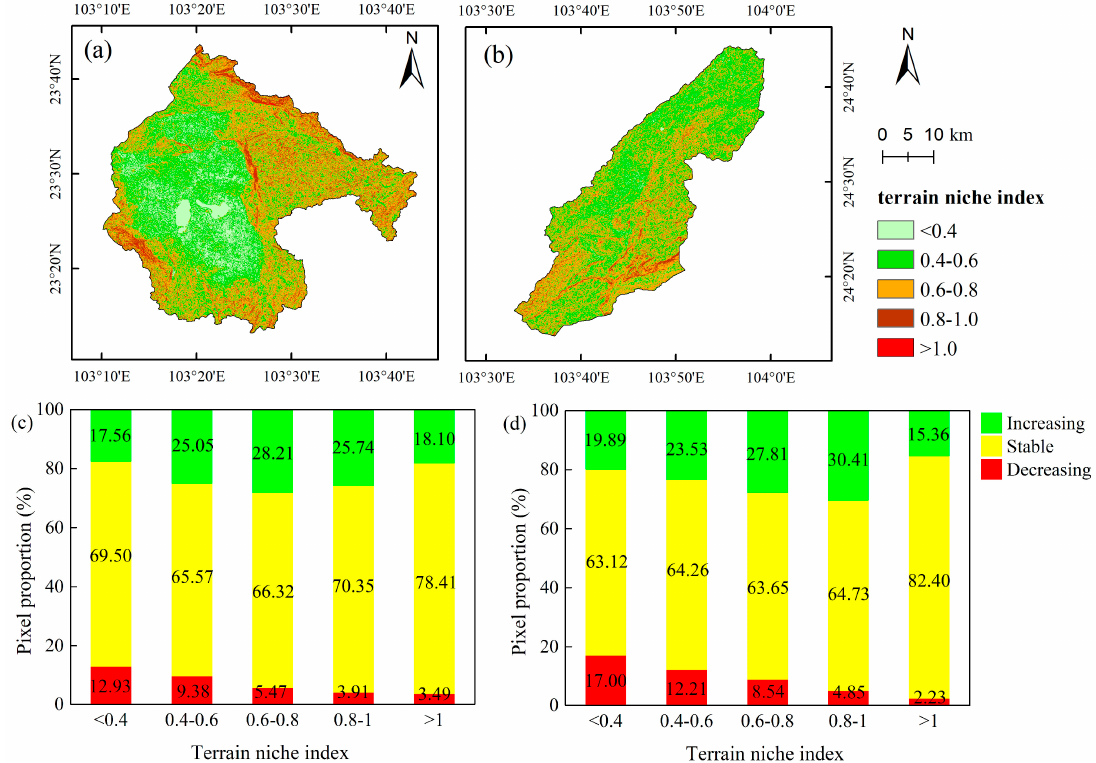
Figure 8. The spatial distribution of the terrain niche index (TNI) values in: ( a ) Nandong; and ( b ) Xiaojiang watersheds; and the pixel proportion of vegetation cover trends for different terrain niche index (TNI) intervals in; ( c ) Nandong; and ( d ) Xiaojiang watersheds.